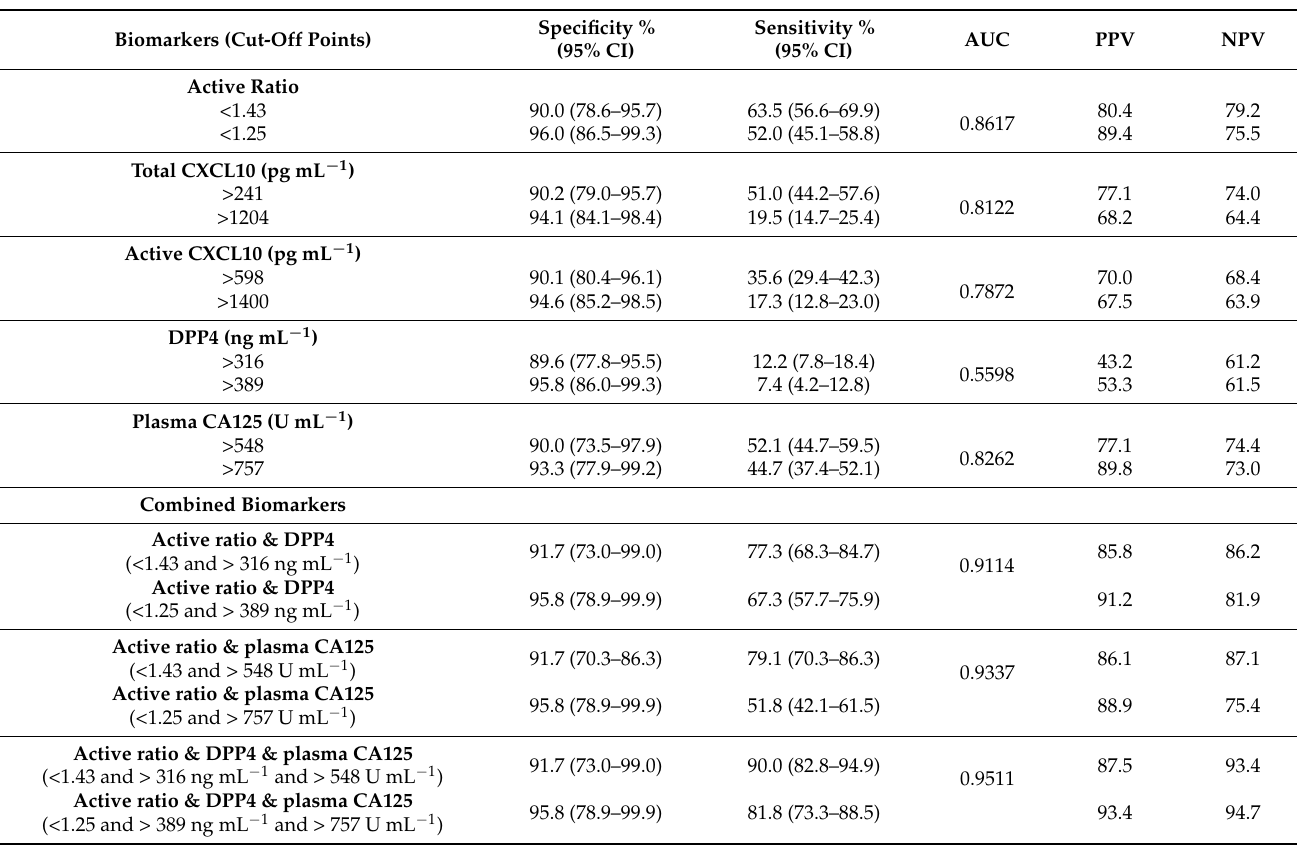
Table 3. Prognostic performance of active ratio and other biomarkers in the ascites fluid from ovarian cancer patients to distinguish between benign and malignant.